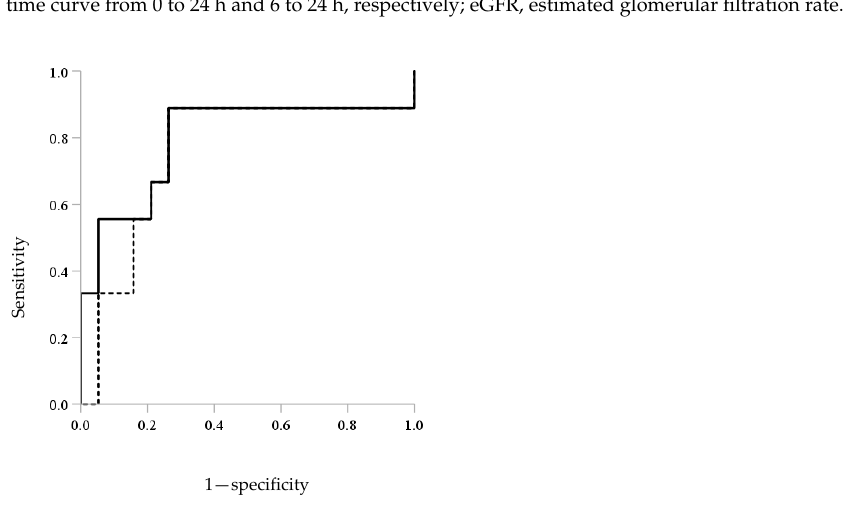
( b ) Figure 3. Kaplan–Meier analysis for time to the incidence of grade 2 diarrhea based on the cut-off values of AUC 0–24 (823.5 ng·h/mL) and C 0 (28.5 ng/mL) of afatinib. Kaplan–Meier curves for the incidence of grade 2 diarrhea in patients with ( a ) AUC 0–24 of greater than or equal to 823.5 ng·h/mL (solid line) and less than 823.5 ng·h/mL (dotted line) and with ( b ) C 0 of greater than or equal to 28.5 ng/mL (solid line) and less than 28.5 ng/mL (dotted line). 3.5. Prediction Formulae to Estimate the Afatinib AUC 0–24 The derived prediction formulae and r 2 values for the estimation of the AUC 0–24 of afatinib with a single point and with the best two-point combinations are shown in Table 4. Although a significant correlation between the AUC 0–24 and C 0 of afatinib was observed ( r 2 = 0.761; p < 0.001), the predicted AUC 0–24 of afatinib from the single point of C 6 showed the highest correlation with the measured AUC 0–24 (predicted AUC 0–24 = 14.0 × C 6 + 214.6, r 2 = 0.840; p < 0.001). In addition, the predicted AUC 0–24 of afatinib from the two points of C 0 and C 6 showed the highest correlation with the measured AUC 0–24 (predicted AUC 0–24 = 10.6 × C 0 + 9.1 × C 6 + 135.4, r 2 = 0.911; p < 0.001).